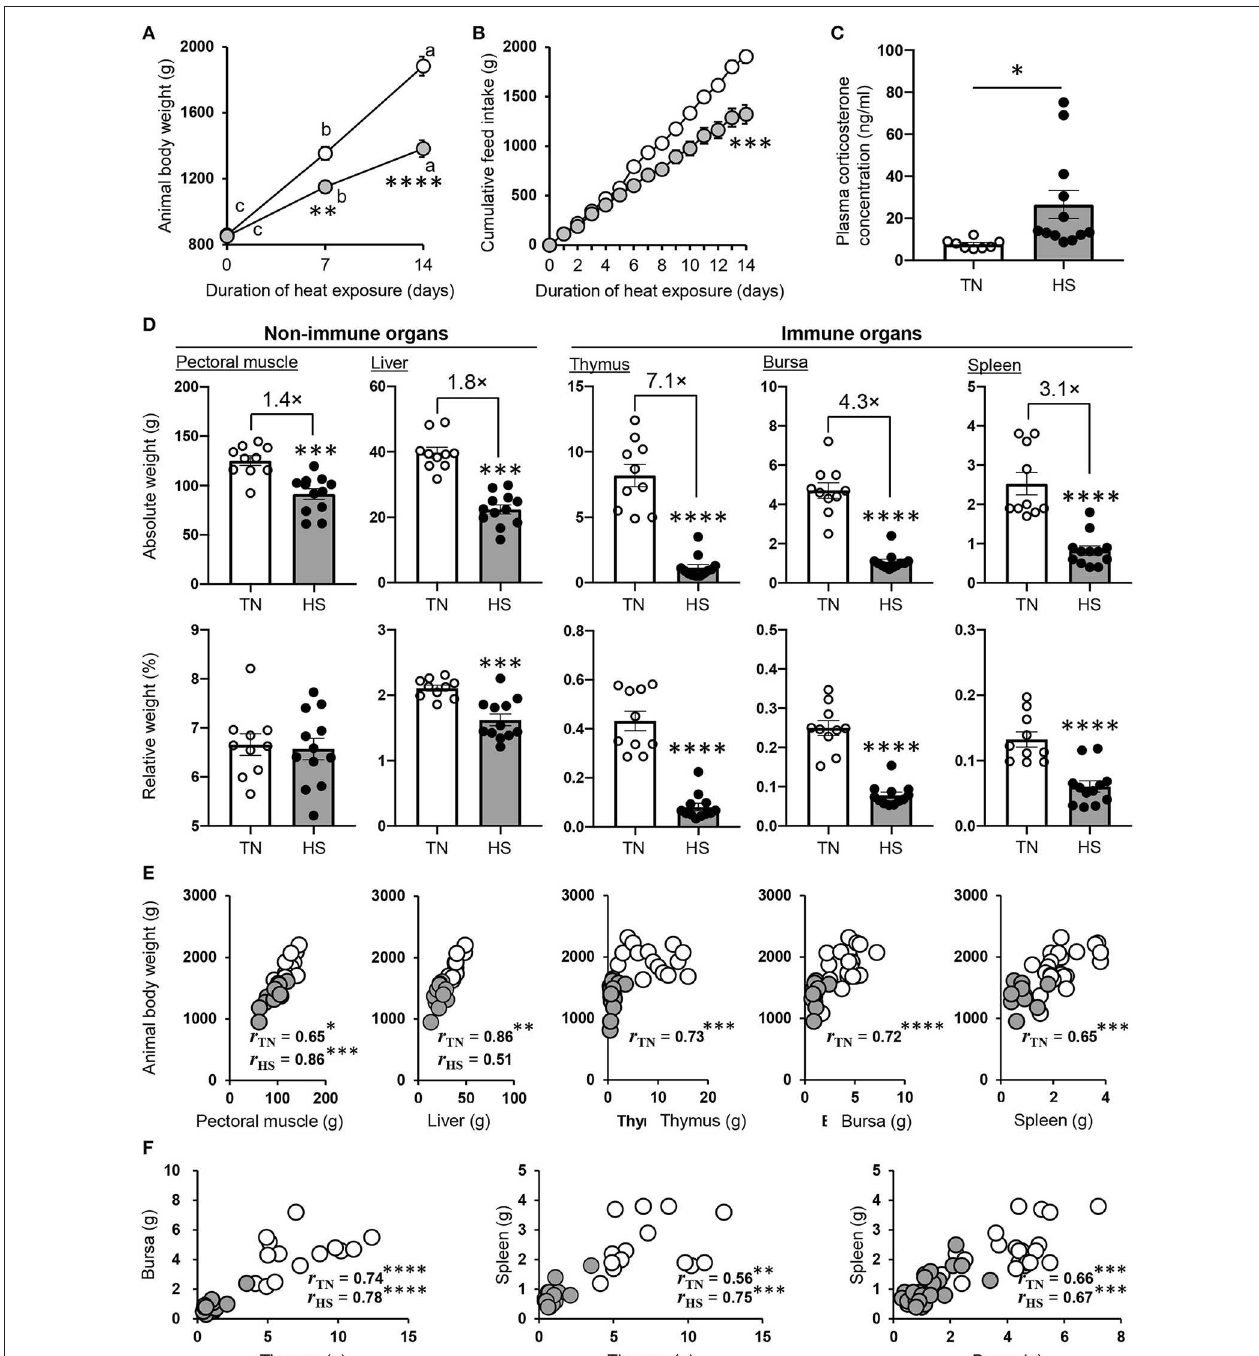
FIGURE 1 | Performance parameters of broiler chickens under the HS condition. (A,B) The chickens were maintained under the TN (24 ± 0.5 ◦ C) or HS (34.5 ± 0.5 ◦ C) condition. The HS and TN conditions are indicated by gray and clear circles, respectively. Animal body weight (A) and cumulative feed intake (B) of each group were measured for 2 weeks (22–36 days old). (C) The plasma CORT concentration was analyzed in both groups at 36 days of age. (D) The pectoral muscle, liver, thymus, bursa of Fabricius, and spleen were harvested from each group at 36 days of age, and their absolute and relative weights were measured. Three experiments were conducted and a representative result was shown in (A–D) . (E,F) The relationship between body weight, the weight of each tissue (E) , and among the weight of lymphoid tissues (F) obtained from all three experiments conducted were evaluated by Pearson correlation analyses. The data are presented as means ± SE ( n = 10–12/group for animal body weight and cumulative feed intake, n = 10–12/group for tissue weight and plasma CORT concentration). * p < 0.05, ** p < 0.01, *** p < 0.001, **** p < 0.0001 compared with the TN group (unpaired two-tailed Student’s t- test). (A) For points a, b, and c, p < 0.05 compared among each group for the different time